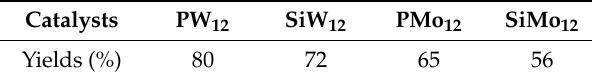
Table 1. 2-Benzoylamino- N -phenylbenzamide yields (%). Catalysts PW 12 SiW